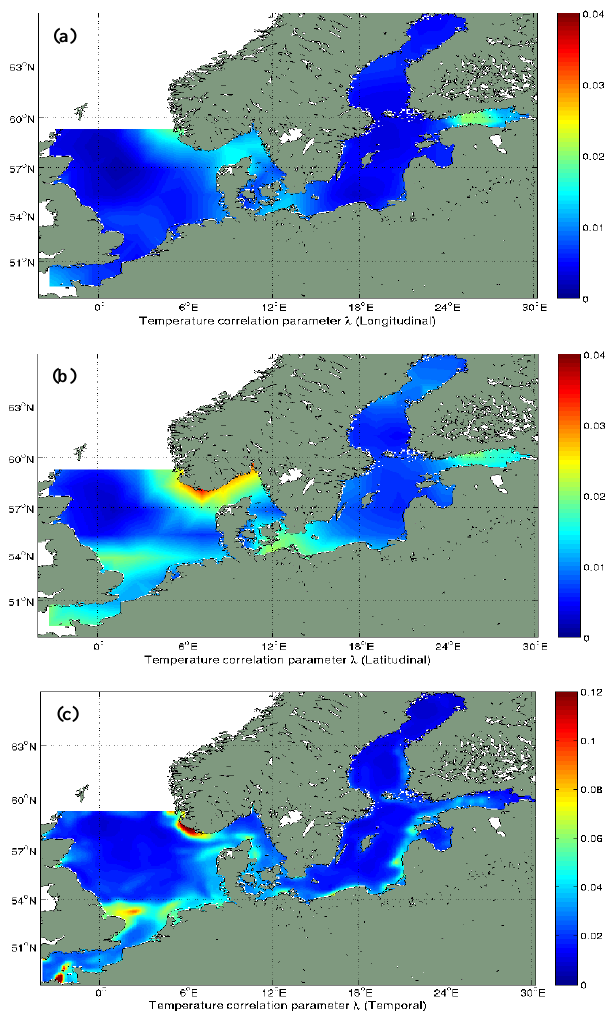
Figure 8, Spatially varying parameters for the correlation model calculated from the proxy SST in the (a) longitudinal, (b) latitudinal and (c) temporal directions.